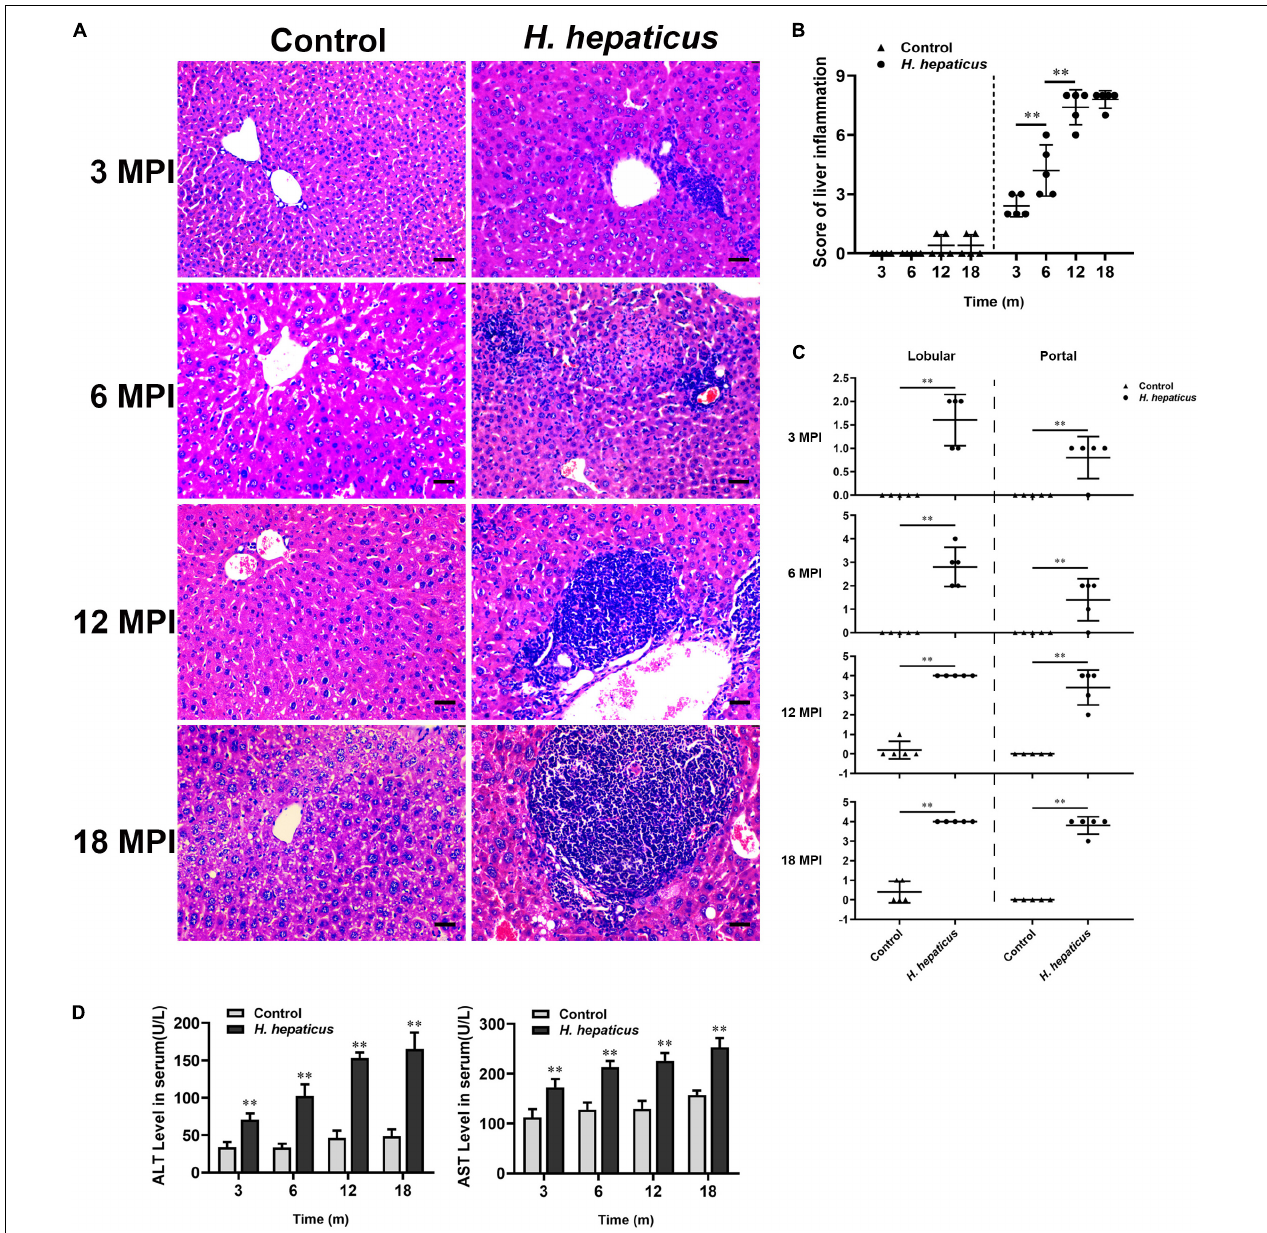
FIGURE 3 | Helicobacter hepaticus infection induced chronic hepatitis. (A) H&E images of the liver from male mice of control and H. hepaticus –infected groups at 3, 6, 12, and 18 months (magnification, × 200). (B) The scores of the degree of hepatic inflammation were calculated by combining the sub-categorical hepatitis scores of mice in the control and H. hepaticus –infected groups at all time points. (C) Scores of sub-categorical lesions of liver in representative mice at all time points. (D) The levels of serum ALT and AST activity between the H. hepaticus –infected groups and control groups. Data are expressed as the means ± SD ( n = 5). ∗∗ p < 0.01 as compared to the control. Each group contained five